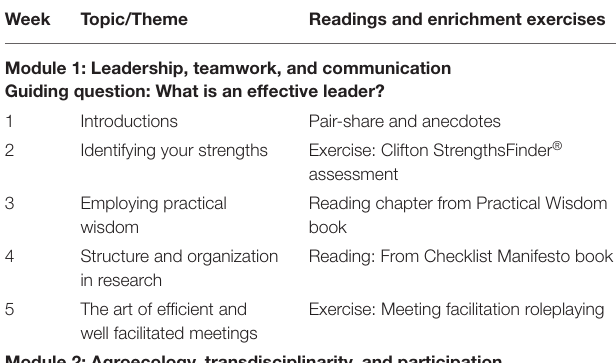
TABLE 1 | UARFP enrichment curriculum.